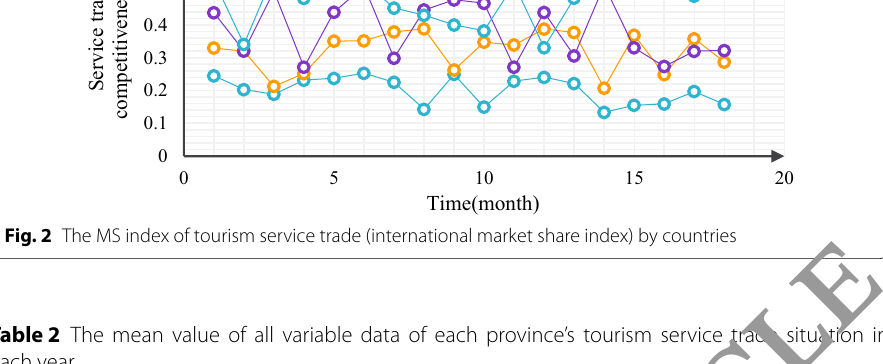
Employees in the tourism industry in each